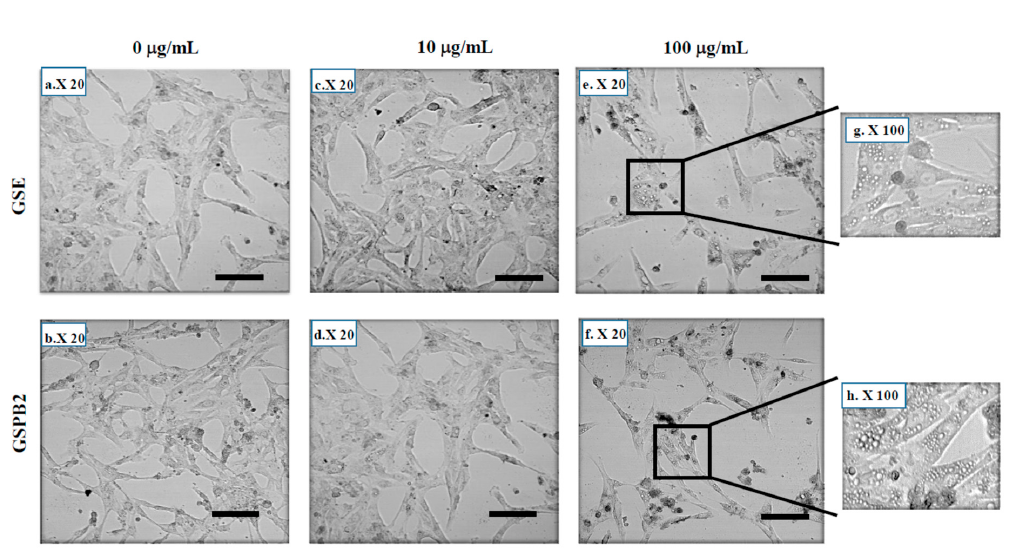
Figure 5. Morphological changes of KGN cells induced by the GSE and GSPB2 treatments for 24 h. KGN were cultured in medium with serum in the presence or in the absence of various doses of GSE or GSPB2 (0, 10, and 100 μ g/mL). Photographs were taken 24 h after incubation with GSE and GSPB2. In the presence of 100 μ g/mL of GSE or GSPB2, the KGN cells appeared smaller and wrinkled under the invert microscope and exhibited the classical morphological characteristics of cell death including cell atrophy and increased vacuoles. Scale bars = 25 μ m ( a , b , c , d , e , and f ). Black rectangles in ( e ) and ( f ) are magnified in ( g ) and ( h ), respectively.